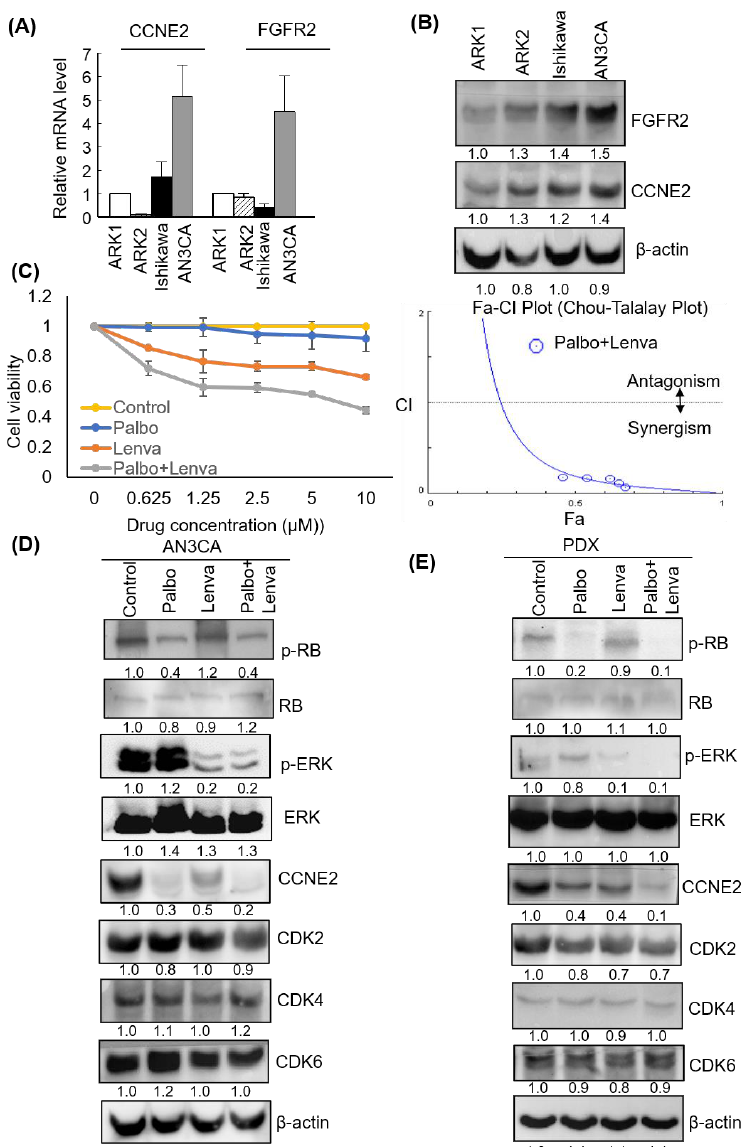
Figure 5. Palbociclib and lenvatinib synergistically inhibited CCNE2 expression levels and decreased viability of endome- trial cancer (EC) cells. CCNE2 and FGFR2 ( A ) mRNA and ( B ) protein expression in ARK1, ARK2, Ishikawa, and AN3CA